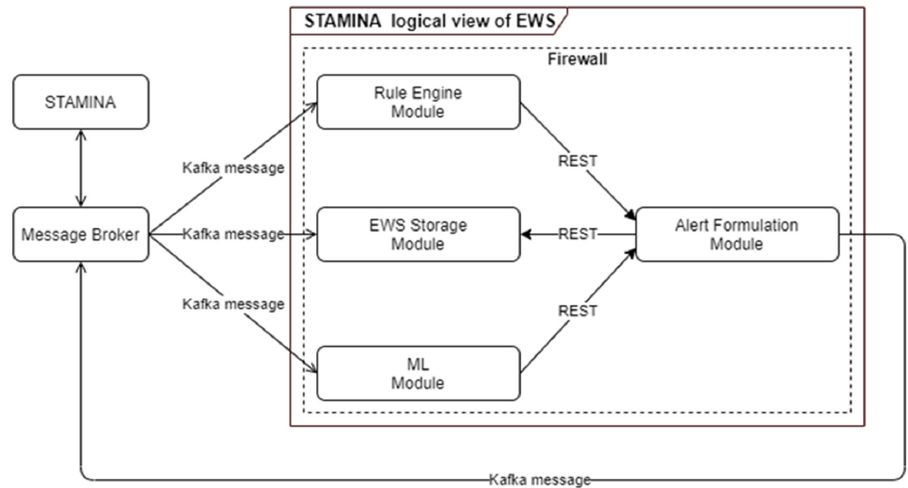
Figure 9. ML-Based Early Warning System Architecture.